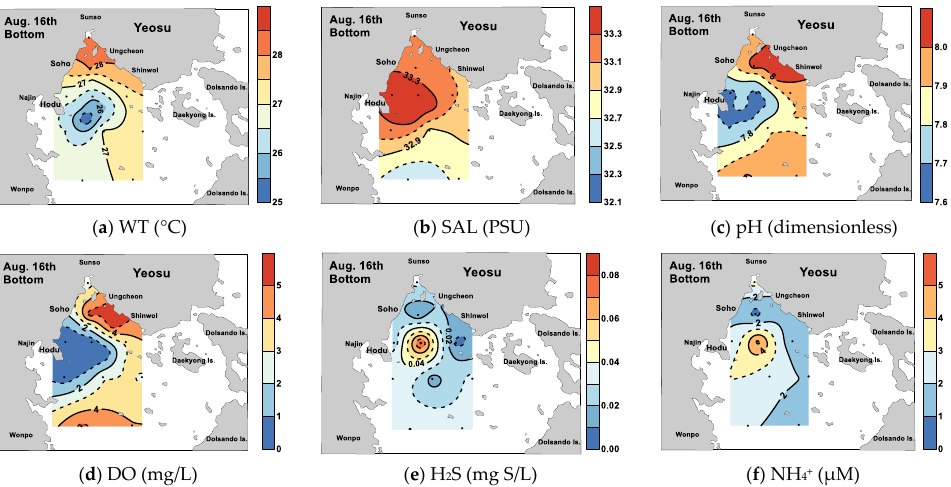
Figure 3. The spatial distributions of bottom seawater quality parameters, in Gamak Bay, Korea, in August 2017, ( a ) Water temperature (WT); ( b ) Salinity (SAL); ( c ) pH; ( d ) Dissolved oxygen (DO); ( e ) Hydrogen sulfide (H 2 S); ( f ) Ammonium-nitrogen (NH 4+ ).